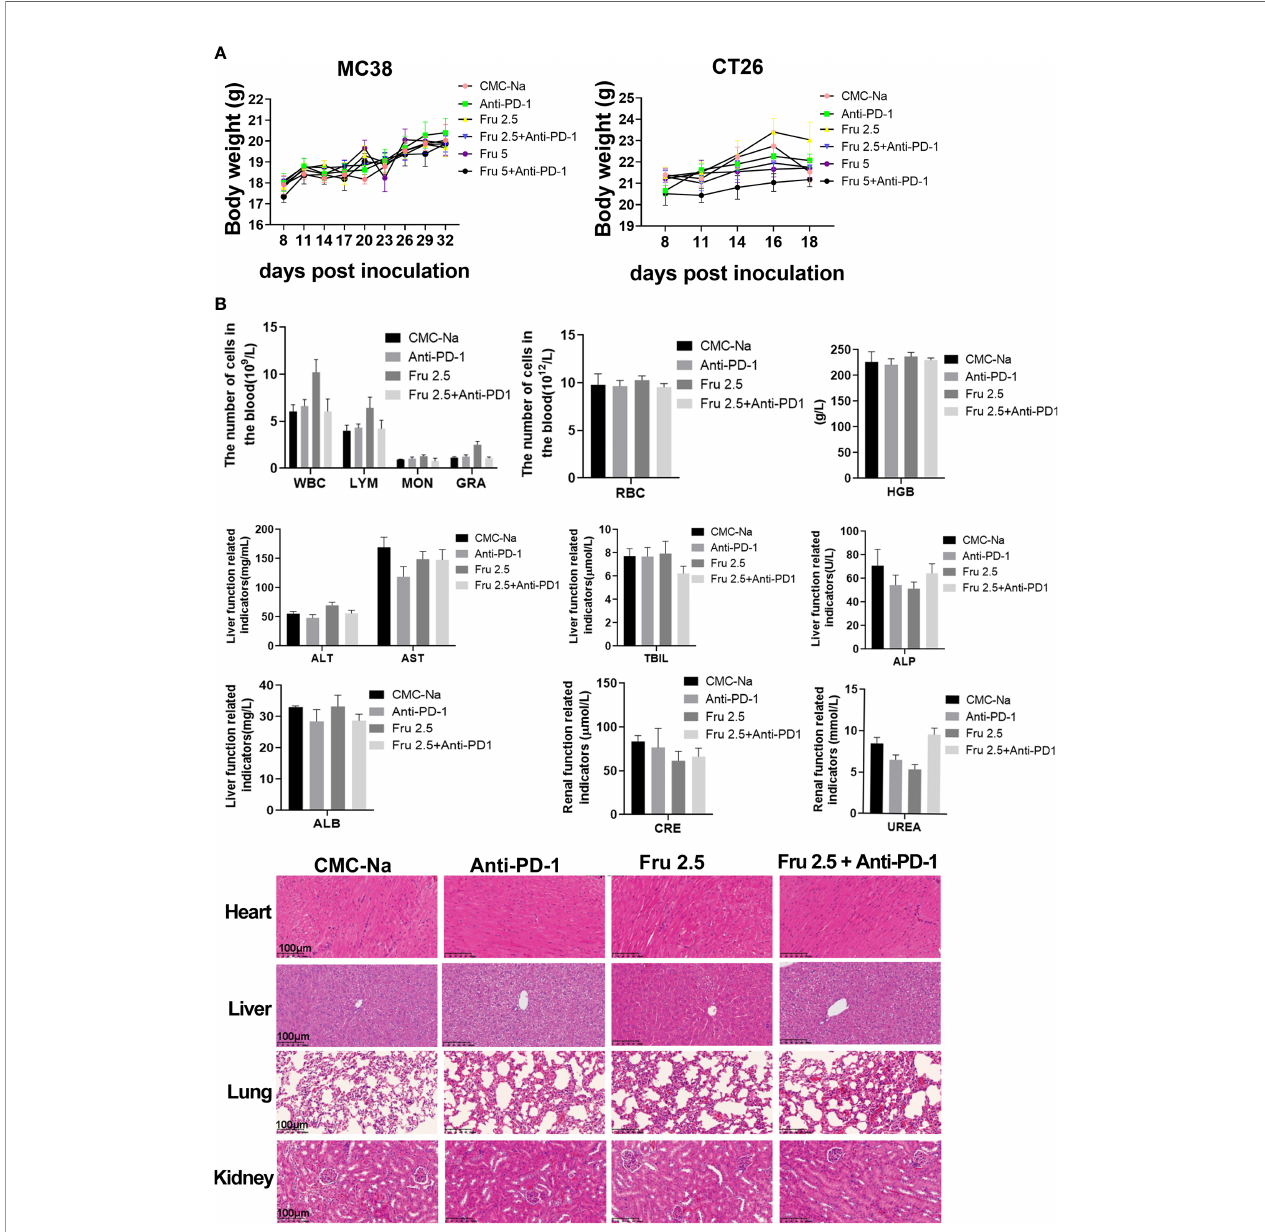
FIGURE 5 | A safety of the combination of fruquintinib and anti-PD-1 in vivo . (A) Body weight of tumor-bearing mice in each group. The weight was measured every three days. (B) Blood cell analysis,liver and kidney function and histopathology morphology of the murine major organs (heart, liver, lung, kidney) in the mouse